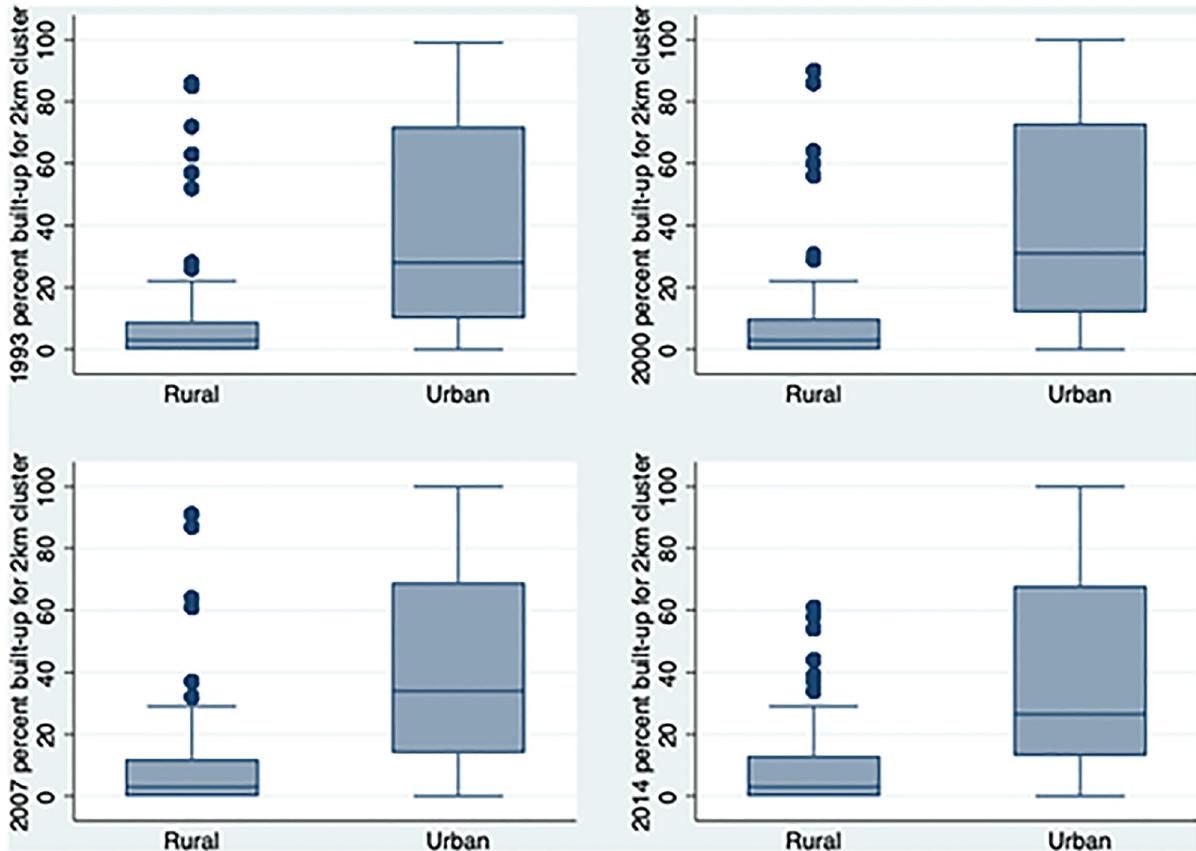
Fig 4. Boxplots of percent built-up by urban-rural clusters, 1993–2014 (IFLS).